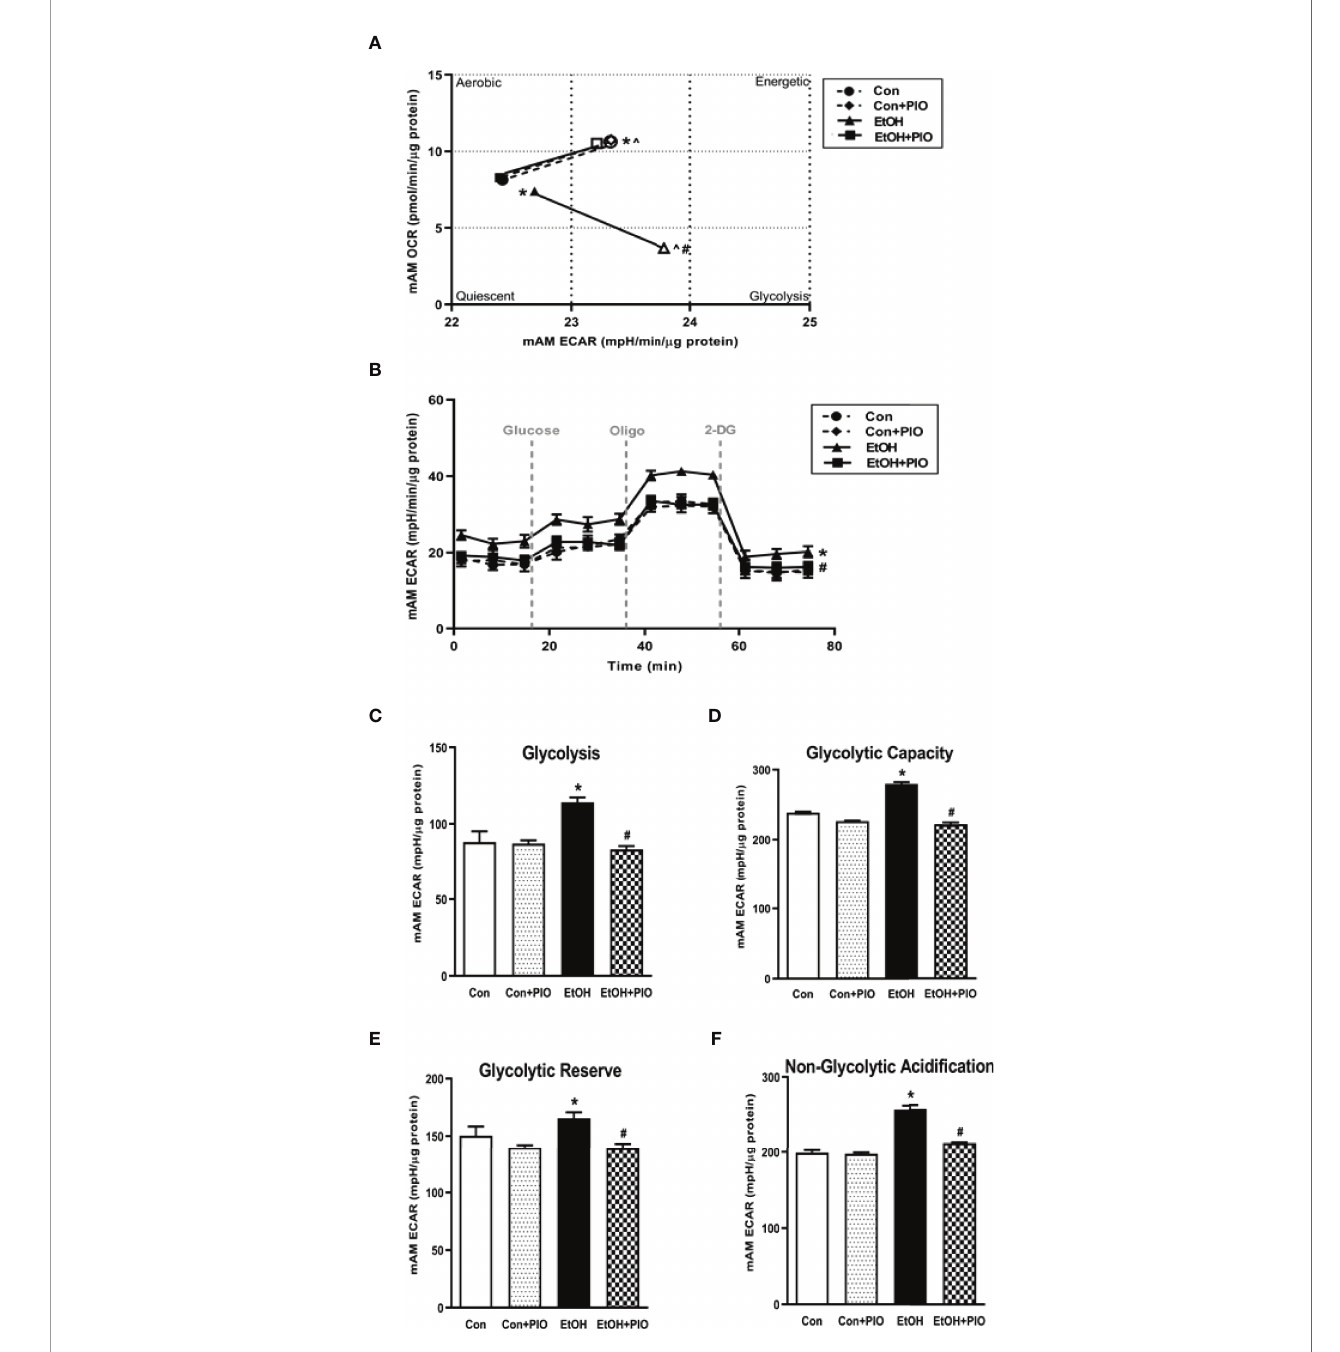
FIGURE 10 | Pioglitazone treatment reverses EtOH-induced glycolysis in mAM. Mouse alveolar macrophages (mAM) were isolated from mice fed either control (Con) or ethanol (EtOH; 20% v/w in drinking water) ± oral pioglitazone (PIO, last 7 days of ethanol). (A) Oxygen consumption rates (OCR) and extracellular acidi fi cation rates (ECAR) were measured in response to an injection mixture of oligomycin (oligo; mitochondrial complex V inhibitor) and carbonilcyanide p-tri fl ouromethoxyphenylhydrazone (FCCP; ATP synthase inhibitor and proton uncoupler) using an extracellular fl ux analyzer. Cell energy phenotype was measured, normalized to protein levels, and are expressed as mean ± SEM (n = 10-12). ECAR were measured in response to sequential injections of glucose (saturating concentration of glucose to promote glycolysis), oligomycin (ATP synthase inhibitor), and 2-deoxy-glucose (2-DG; a glucose analog that inhibits glycolysis) using an extracellular fl ux analyzer. OCR measures are pmol over time and ECAR measures are mpH over time, normalized to total protein in the same sample well, and are expressed as mean ± SEM. Parameters of glycolytic function (B) , glycolysis (C) , glycolytic capacity (D) , glycolytic reserve (E) , and non-glycolytic acidi fi cation (F) are expressed as mean ± SEM, relative to control (n = 11-14). * p < 0.05 versus control; # p < 0.05 versus ethanol; ^ p < 0.05 versus control